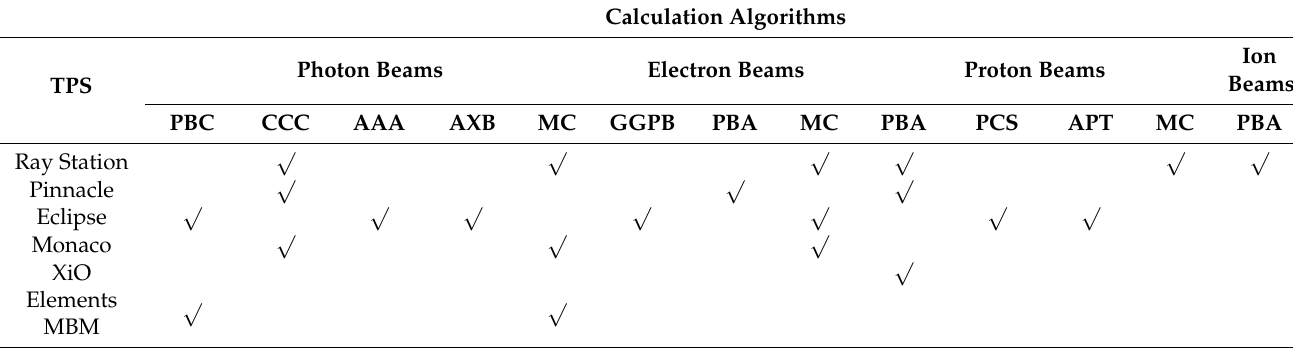
Table 1. Main commercial treatment planning systems available and their respective algorithm options for photon, electron, proton and ion beams. Calculation